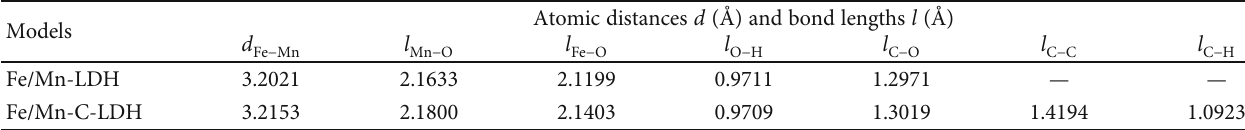
Figure 10: Two density functional theory models of the materials. Table 7: Structure parameters in the models.